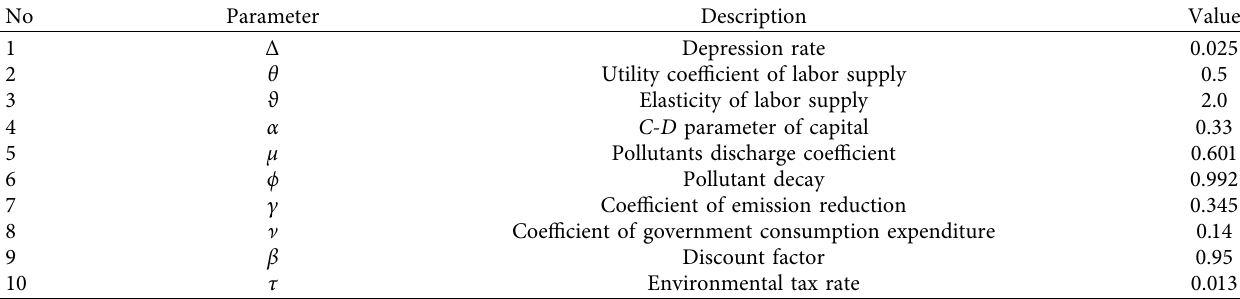
Table 1: Summary of basic parameter values.